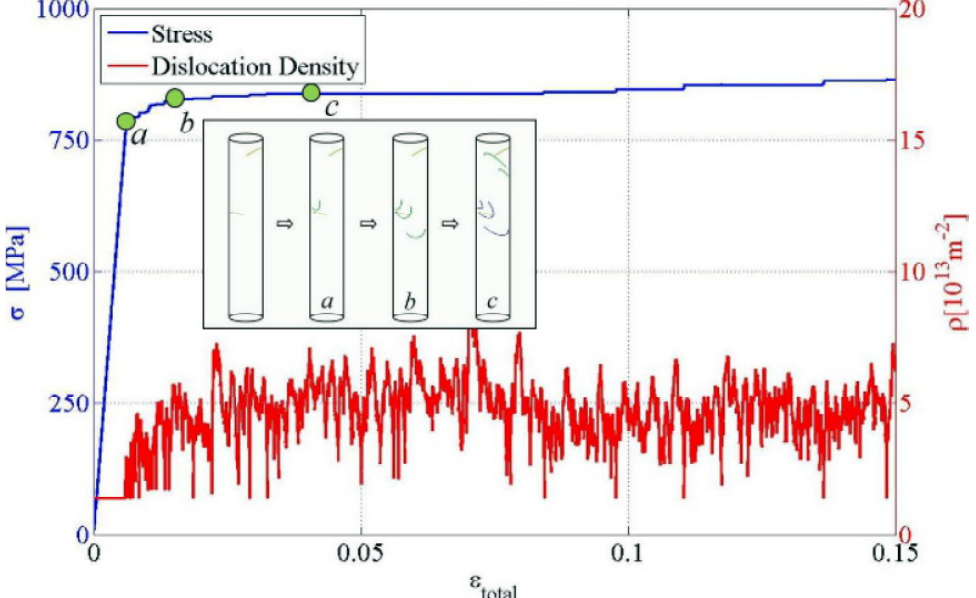
Fig. 16. Stress and dislocation density evolution versus strain for a 150 nm diameter Cu pillar. Insets show the dislocation microstructures at different points along the stress–strain curve. Reprinted with permission from Ryu I, Cai W, Nix WD, Gao H. 2015. Stochastic behaviors in plastic deformation of face-centered cubic micropillars governed by surface nucleation and truncated source operation. Acta Materialia 95, [202]: (c) 2015 Elsevier